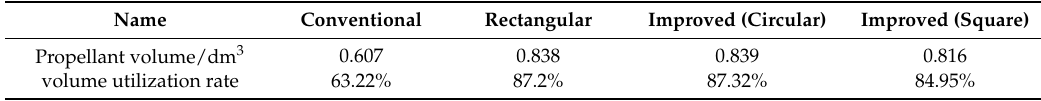
Table 4. Propellant volume and volume utilization ratio of four storage tanks.